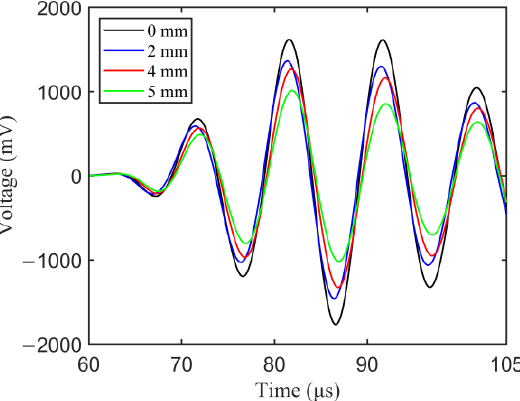
Figure 6. Simulated Lamb wave response signals of different crack length.